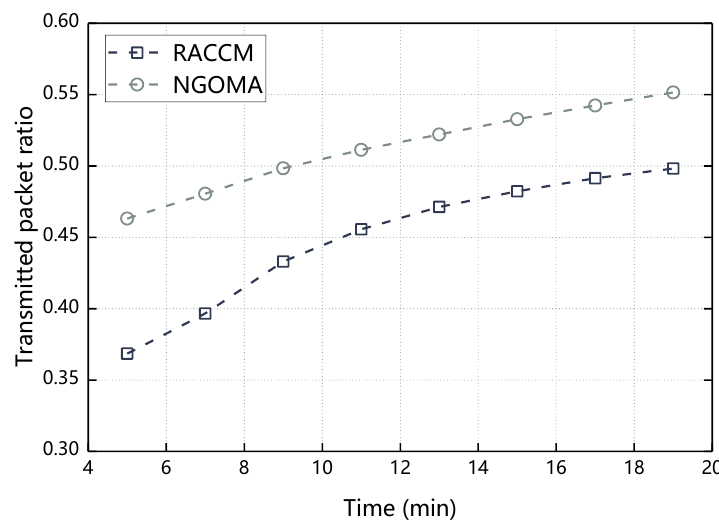
Figure 13. Transmitted packet ratio with respect to time.